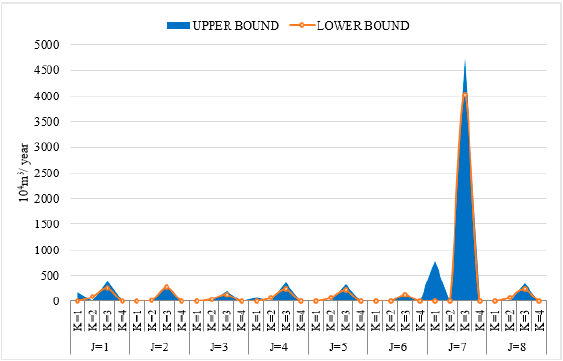
Figure 13. Water shortage in different water use departments in different situations in the third planning